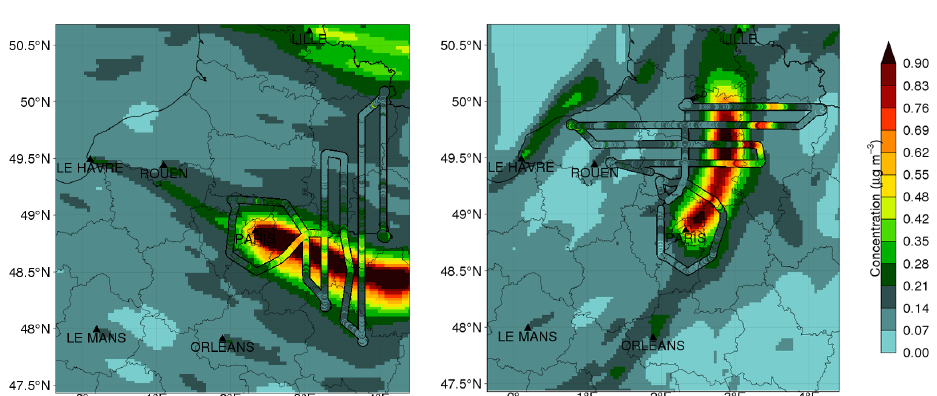
Figure 5. Observed (along the aircraft trajectory) and modeled (in the background, with the TNO-MM5 case) BC concentration for 10 (left panel) and 13 July (right panel). Paris and some other large cities are indicated. Simulated concentrations shown here are taken at 13:00UTC on the fourth layer, which roughly corresponds to 470–870m height. The solid black line corresponds to the flight path outside that layer (altitude above 870 or below